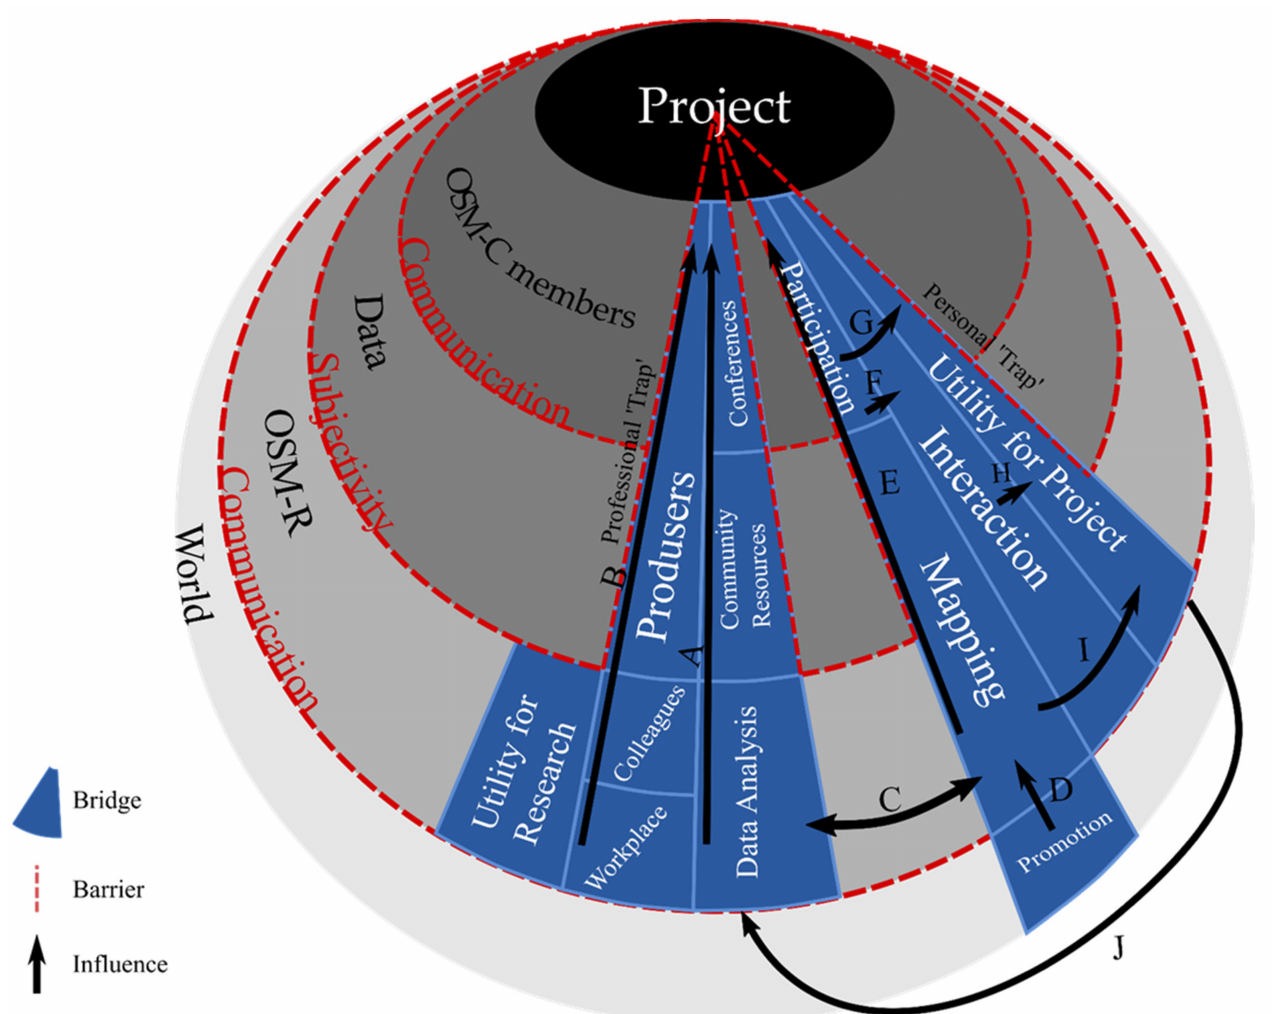
Figure 8. A model of bridges and barriers in engagement between the OSM-R and